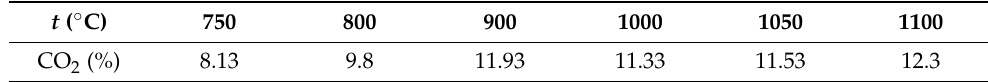
Figure 4. Model 3 of hydrogen H 2 .